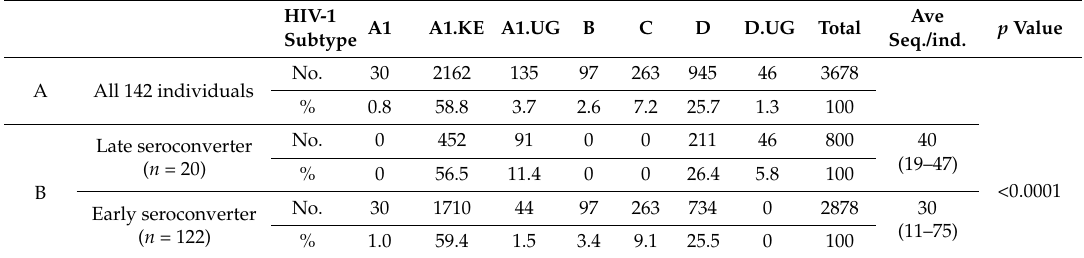
Figure 2. HIV-1 subtype distribution among late seroconverters and early seroconverters. *** : p value is less the 0.0001. Table 1. Comparison of HIV-1 subtype distribution among late seroconverters and early seroconverters.